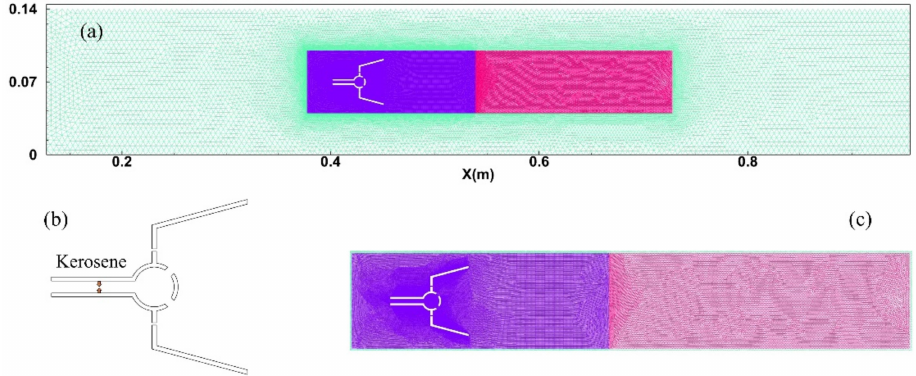
Figure 6. Flameholder structure and grid: ( a ) whole grid of combustor, ( b ) flameholder structure, ( c ) local grid of flameholder.